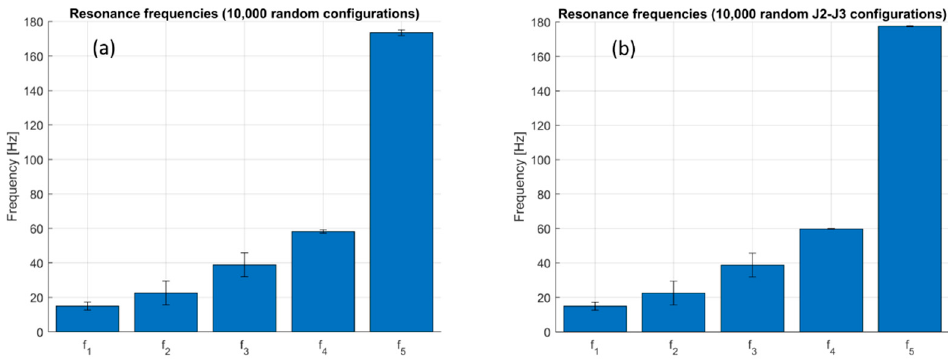
Figure 12. Mean values and standard deviations of natural frequencies in the workspace, ( a ) random variations of J2, J3, J4, J5, ( b ) random variations of J2 and J3.